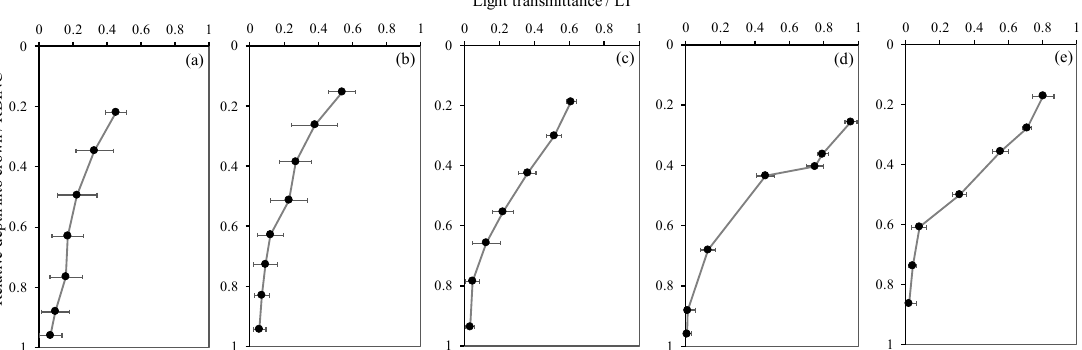
Figure 2. Vertical patterns of light transmittance (The ratio of photosynthetically active radiation in the crown to the incident photosynthetically active radiation, LT) for the planted Larix olgensis Henry trees. (a~e) represents Tree I ~ Tree V. The dark circles are the mean LT in each pseudowhorl, and the black bars are standard deviations.